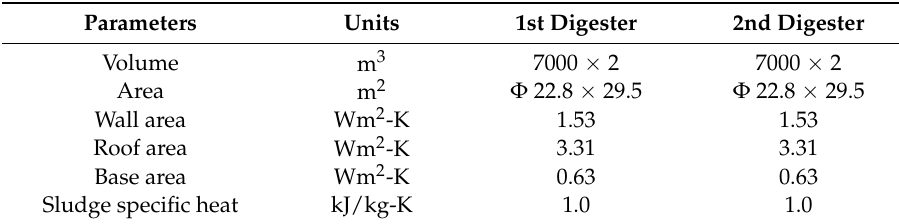
Table 10. Parameters for calculation of the thermal load in the biogas